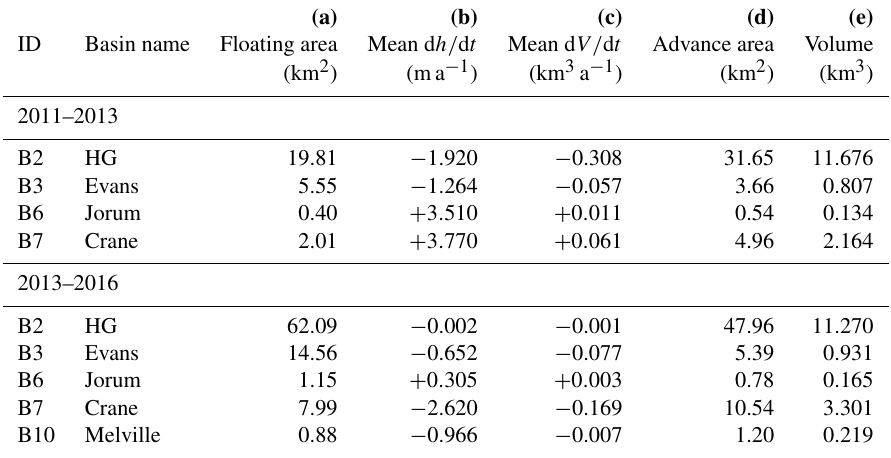
Table 6. (a) Area extent of floating ice in 2013 (top) and 2016 (bottom); (b) and (c) show the rate of surface elevation change and volume change in floating ice from 2011 to 2013 (top) and from 2013 to 2016 (bottom); ( a–c ) exclude the areas of frontal advance; (d) and (e) show the extent and volume of frontal advance